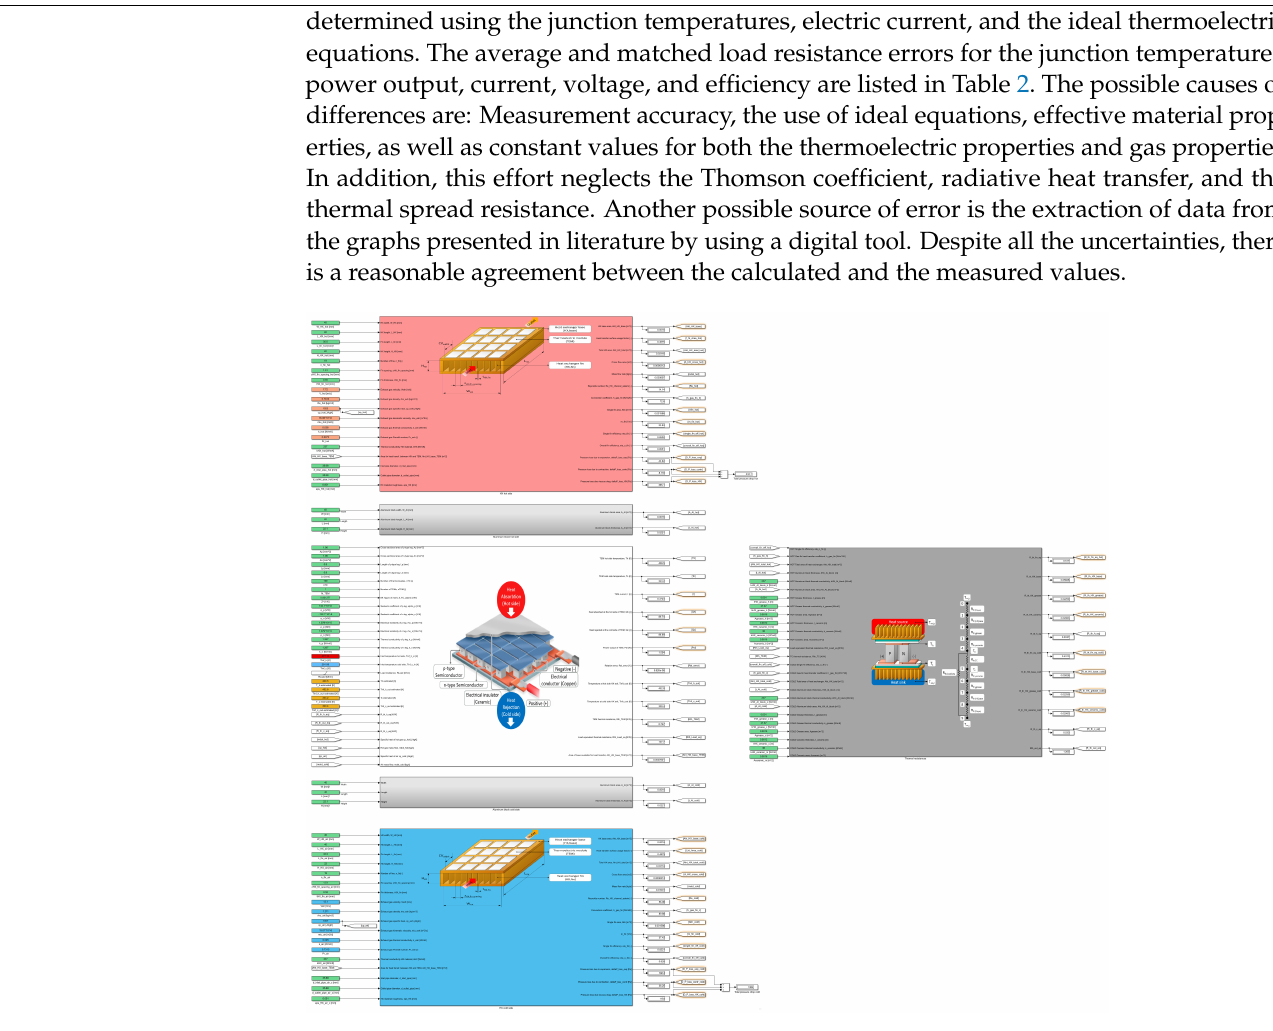
Figure 13. Simulink model with two heat exchangers (red—hot side and blue—cold side), aluminum 13 blocks for thermal spread (light grey), the TEM between, and the thermal resistance network on right side. Table 2. Comparison of calculated and measured values at peak measured